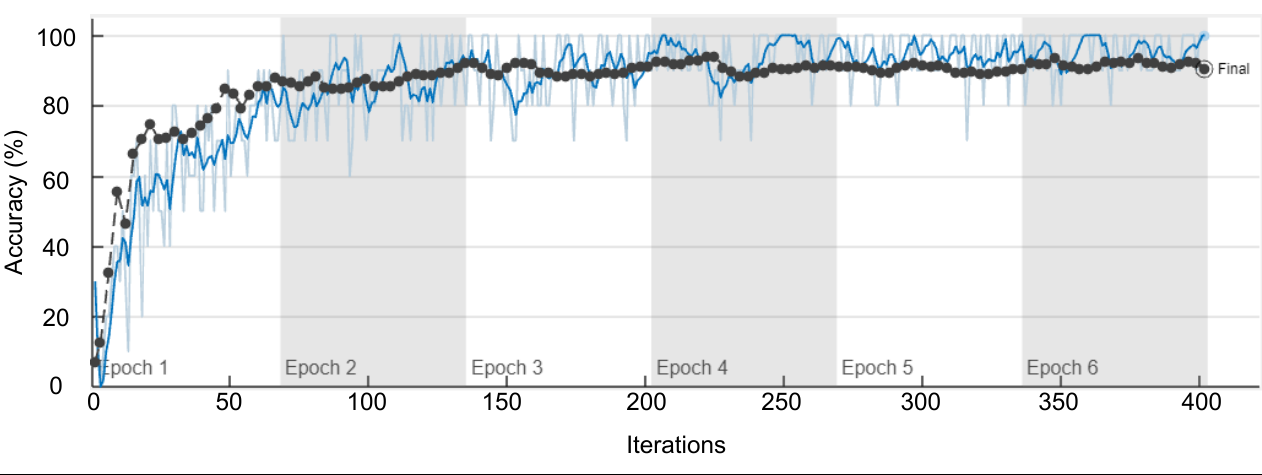
Figure 14. Accuracy versus iteration graph for buttercup image.